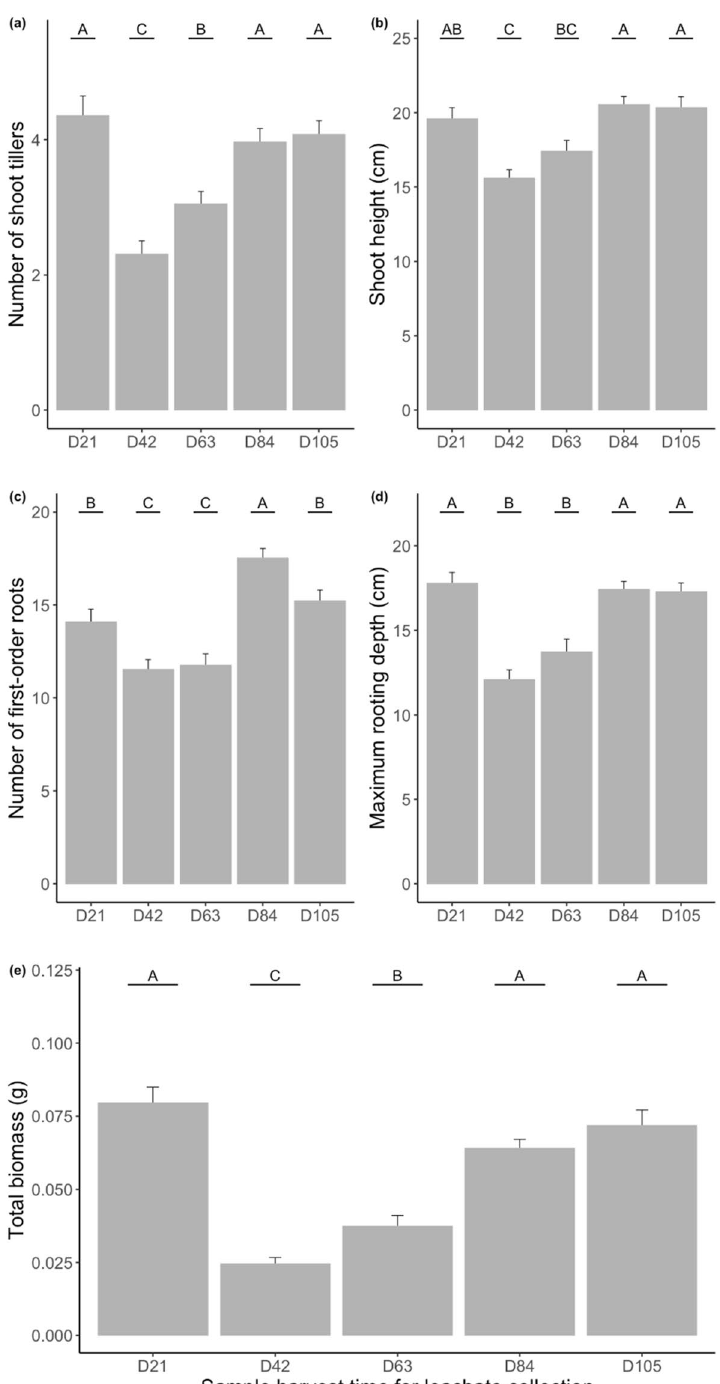
Figure 3. Effect of timing of leachate collection on the number of shoot tillers ( a ), shoot height ( b ), number of first-order roots ( c ), maximum rooting depth ( d ) and total biomass of the entire plant ( e ) in plants receiving leachates from donor plants with or without root-knot nematodes (bars represent averages across nematode and control treatments and across sampling distances). D21, D42, D63, D84, D105 indicate the leachate collection time in number of days (D) after nematode inoculation or water addition. Different letters above the means indicate significant differences between treatments based on Tukey multiple comparison test. Bars are mean ± SE (n =